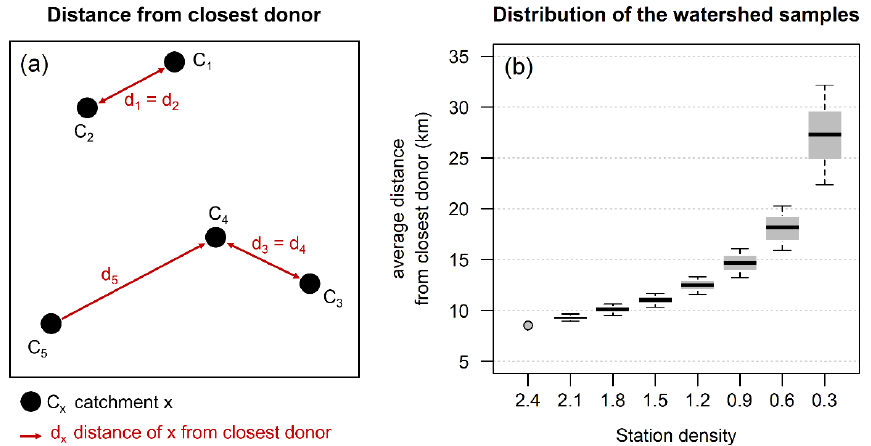
Figure 11. (a) Example of distance from the closest donor. (b) Boxplots of the average distance from the nearest available potential donor across the 100 generated subsets, for different values of station density (gauges per 1000km 2 ). Whiskers extend to the 10th and 90th percentiles. The grey dot (density = 2 . 4) indicates the average distance from the closest donor in the original